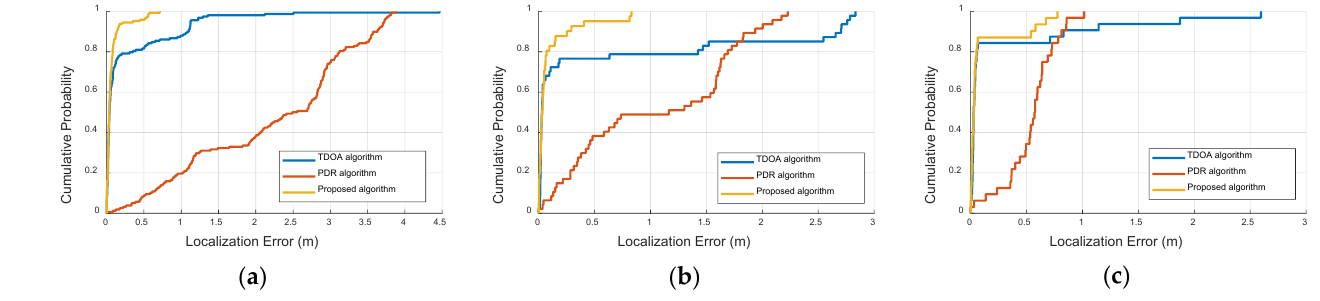
that the TDOA estimation is approximately 1.43 m when the accumulative probability